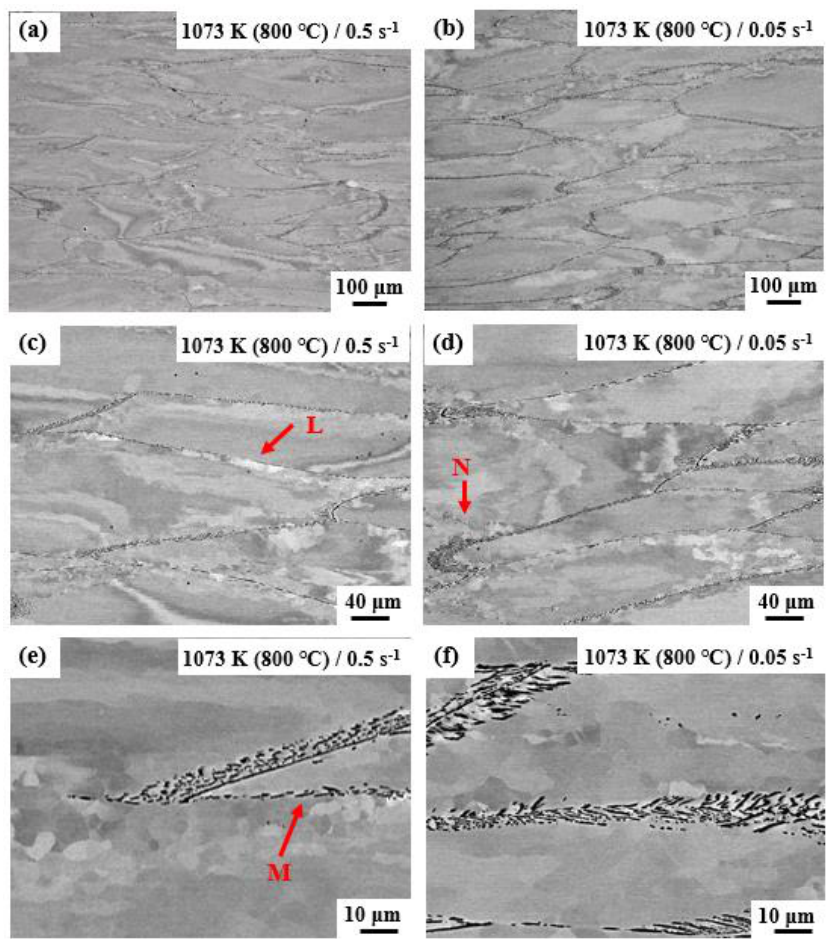
Figure 9. Deformed microstructures at 1073 K (800 °C) for the strain rates of 0.5 s −1 ( a , c , e ) and 0.05 s −1 ( b , d , f ). Here, ( c , e ) are the enlarged areas in ( a , d , f ) are the enlarged areas in ( b